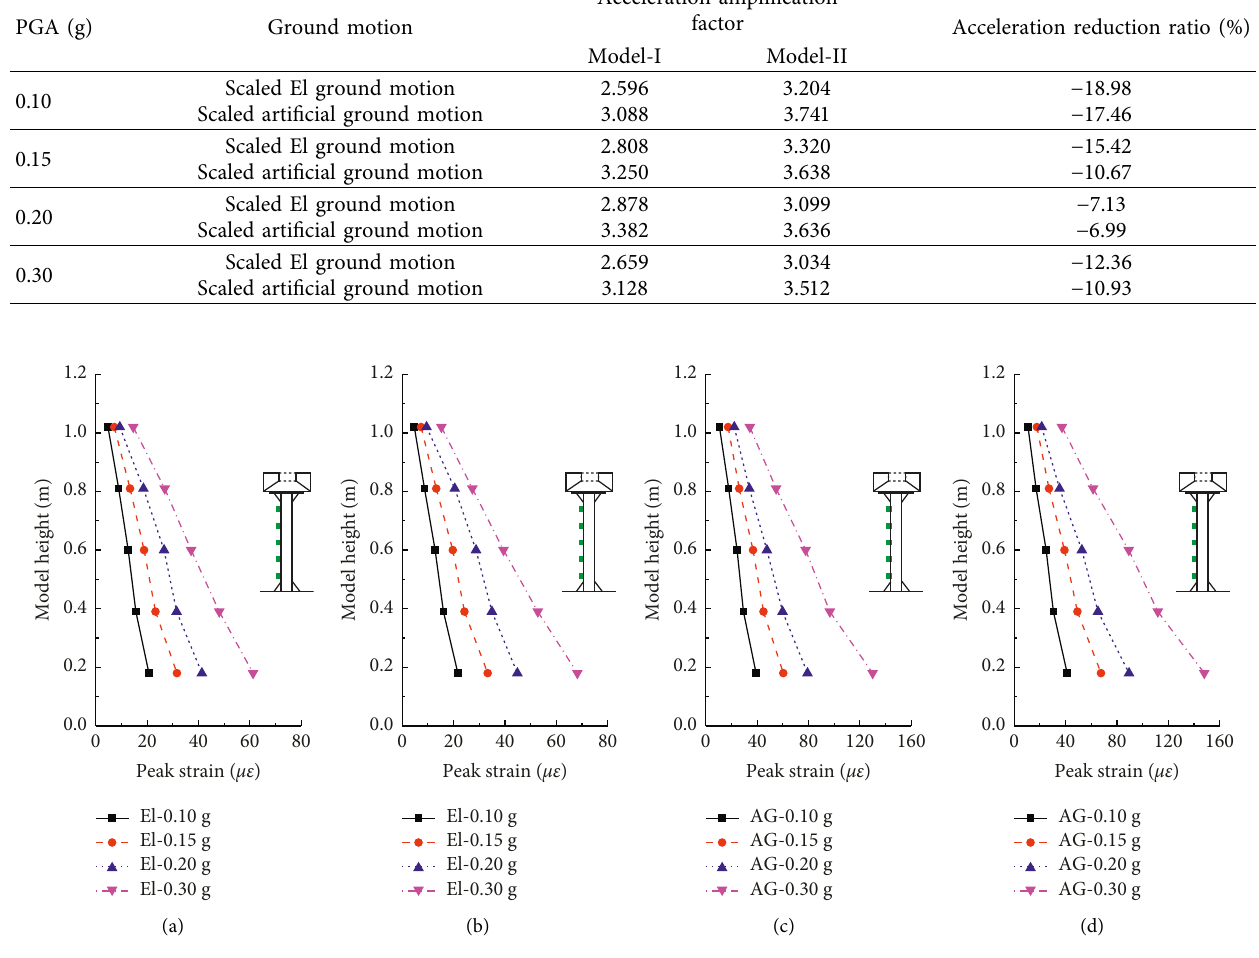
Figure 11: Peak strain curves under different inputs. (a) El-M1. (b) El-M2. (c) AG-M1. (d) AG-M2. Table 7: Peak strain and strain variation factor under scaled El Centro ground